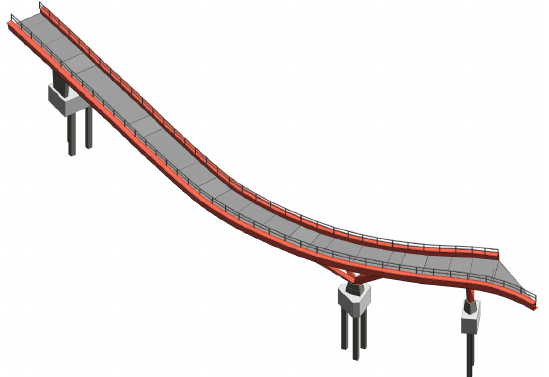
Figure 1. A 3D geometric model of a steel footbridge at Huelva Port